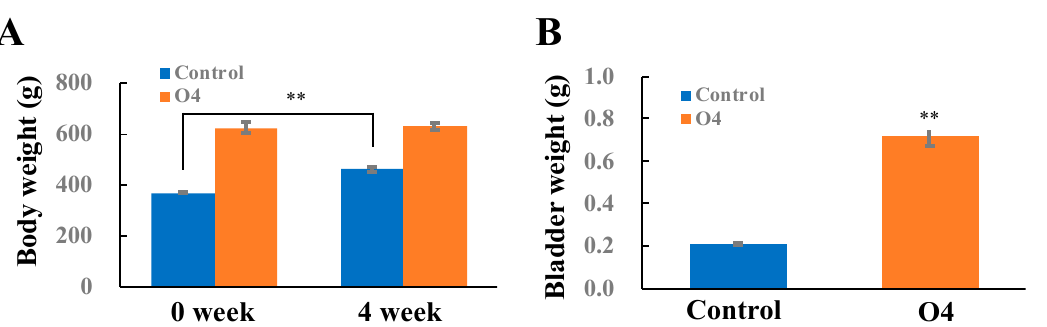
Figure 1. Body weight and bladder weight of rats in the PBOO group and control group. Rat models of PBOO were established as described in the Materials and Methods section. Each rat was weighed before surgery and after surgery for four weeks ( A ). Four weeks after surgery, the rats were sacrificed, and the bladder was collected and weighed ( B ). C: control; O4: four-week PBOO. ** p < 0.01.